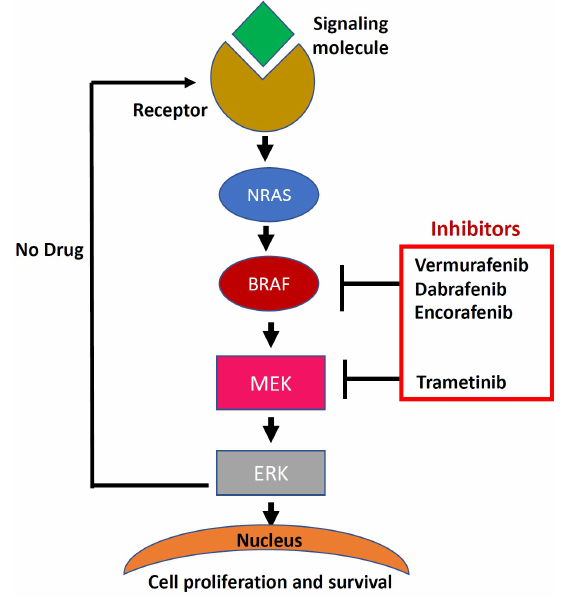
Figure 1. Overview of oncogenic pathways in melanoma and possibilities for targeted inhibition, relevant for the fish models described in this review. The signaling molecule binds to the receptor resulting in phosphorylation and RAS/BRAF and Mitogen-activated protein kinase (MEK) signaling to ERK, thus driving cell growth and survival. Some drugs/inhibitors can be used to block this signaling cascade and to inhibit cancer cell proliferation and